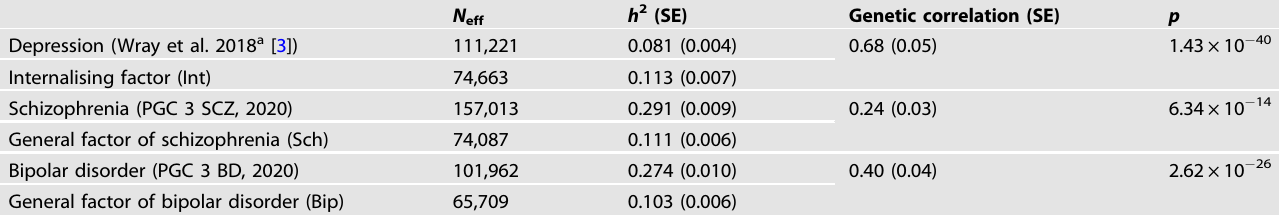
Table 1. Heritability and genetic correlation estimation from using high-de fi nition likelihood inference